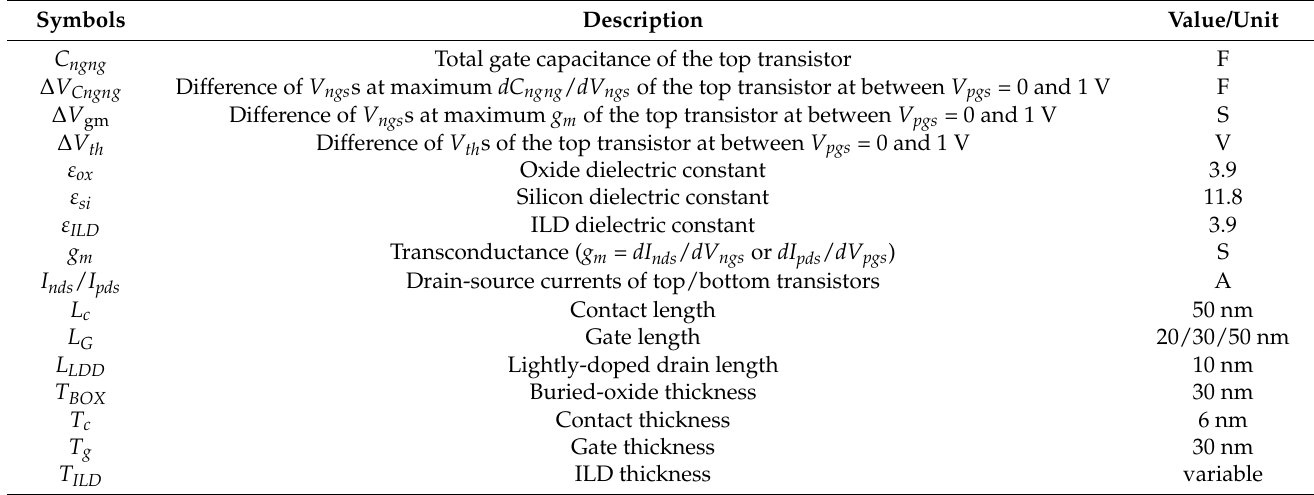
Figure 1. Schematics of two types of monolithic 3-dimensional (3D) inverter (M3INV) cell structure. ( a ) Structure of M3INV-MOS and ( b ) structure of M3INV-JL. ( c ) Equivalent circuit of M3INV-MOS (M3DINV-JL). Table 1. Device/electrical parameter descriptions and dimensions.